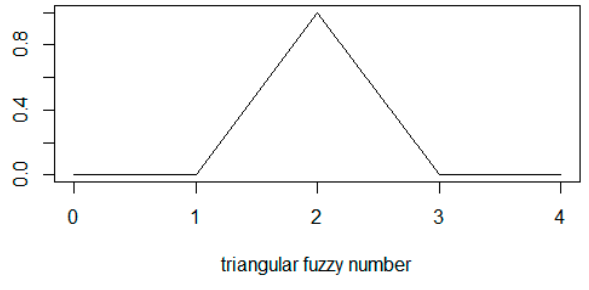
Figure 4. An example of a triangular fuzzy number.